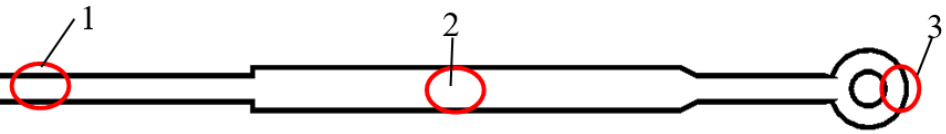
Figure 21. Distribution of the observation points on the cross section of the profile.